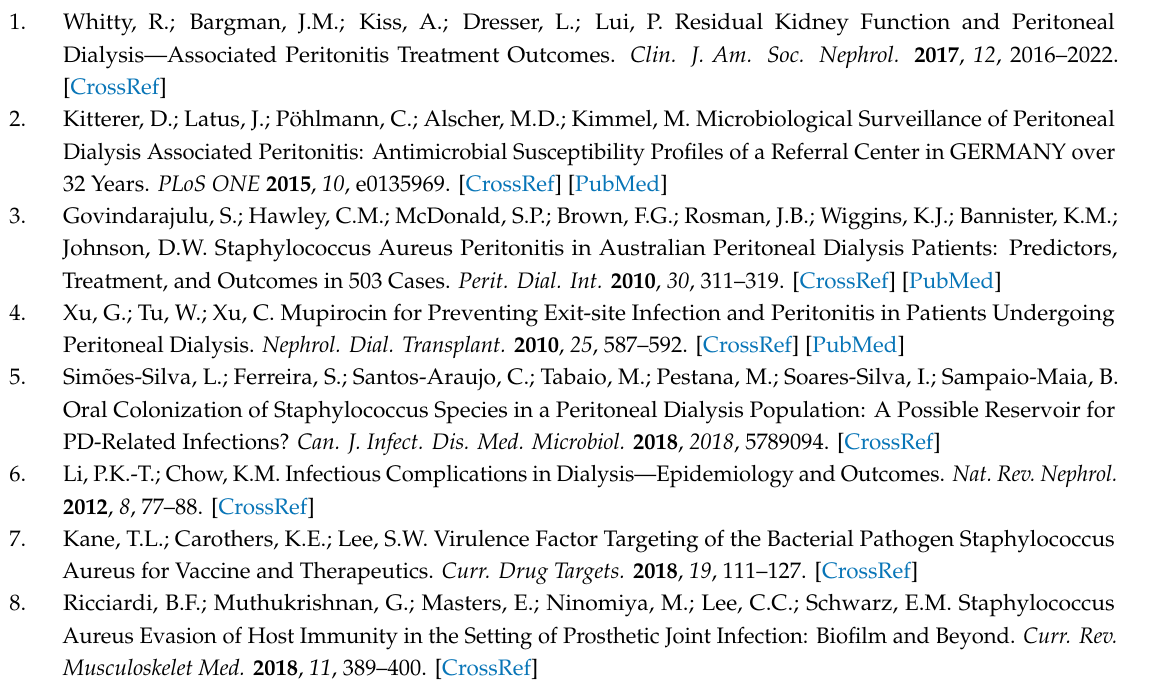
Table S1: Patients characteristics, Table S2: Staphylococcus aureus strain biofilm mean optical density and antimicrobial susceptibility, Figure S1: S. aureus biofilm growth using microtiter plate assay stained with crystal